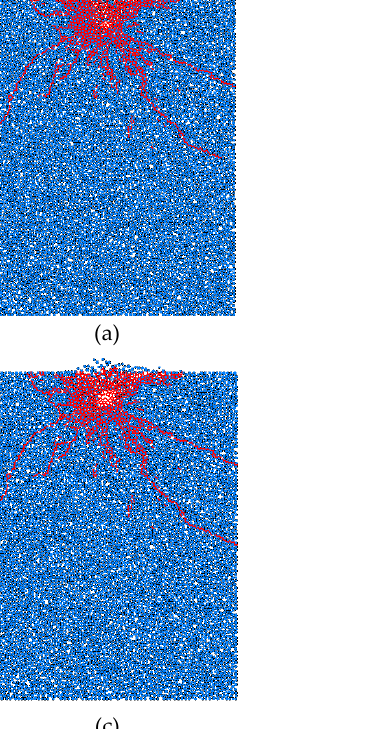
Figure 12. Interior cracking and crack propagation of EPB in granite, C = 0.5 µ F, L = 5 µ H, U = 15 kV: ( a ) t = 80 µ s, ( b ) t = 100 µ s, ( c ) t = 200 µ s, and ( d ) t = 400 µ